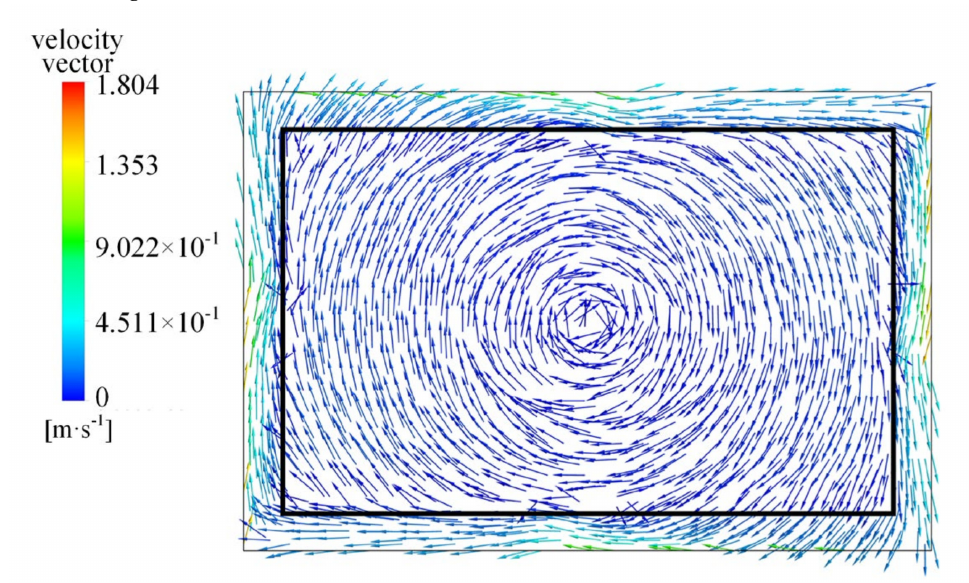
Figure 8. Velocity vector (relative velocity) of airflow above the film (The black, bold box is the substrate